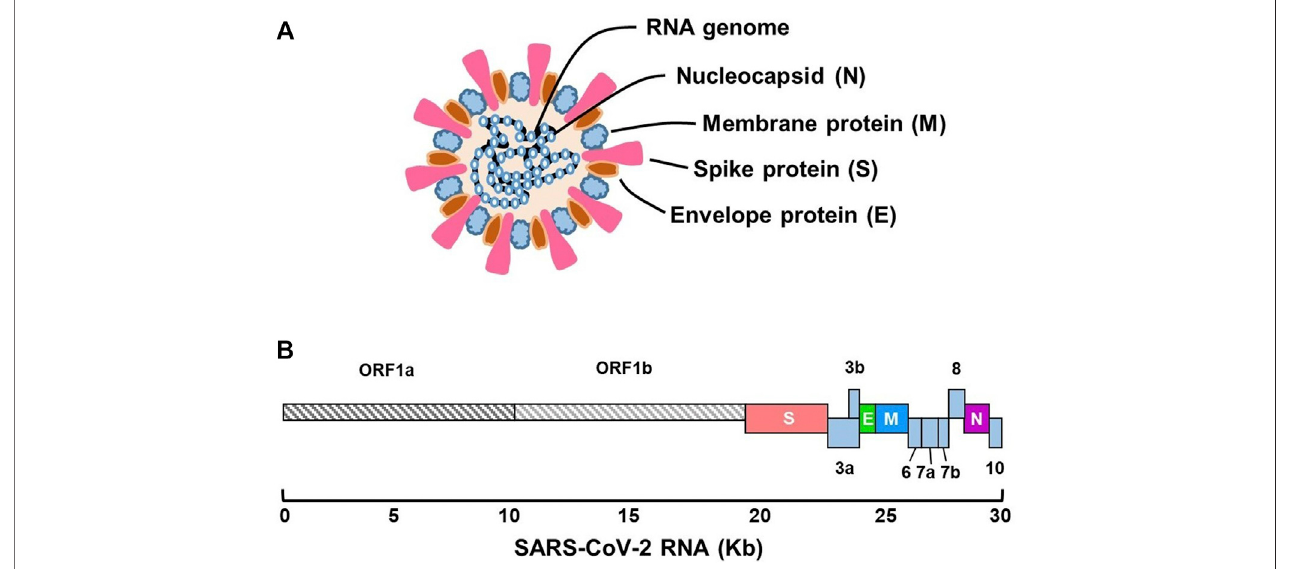
FIGURE 1 | Schematic presentation of the genomic structure of SARS-CoV-2. (A) Virus particle and its components. (B) Genome organization of different functional regions.